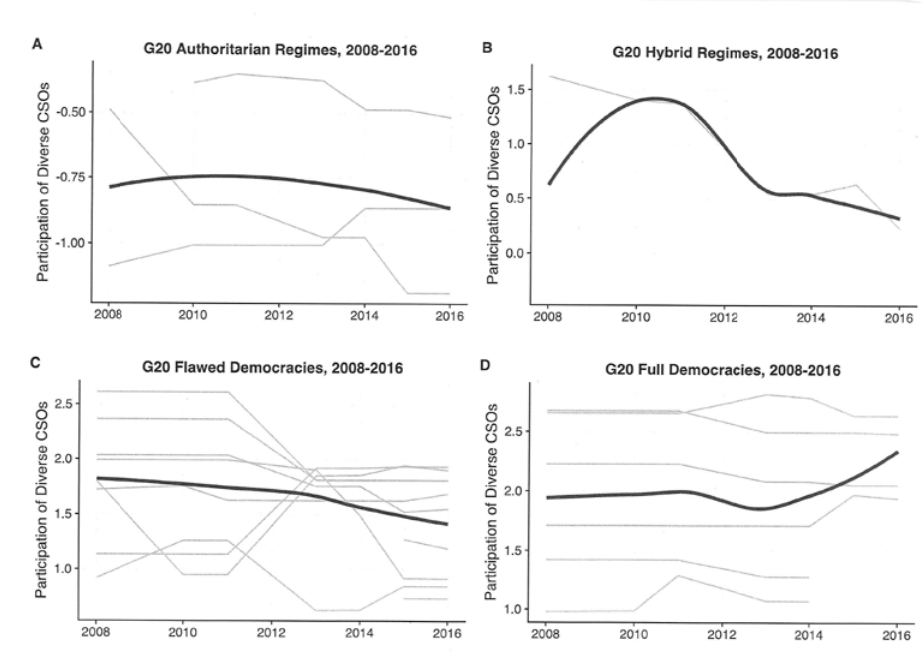
Figure 3 : CSO Diversity and